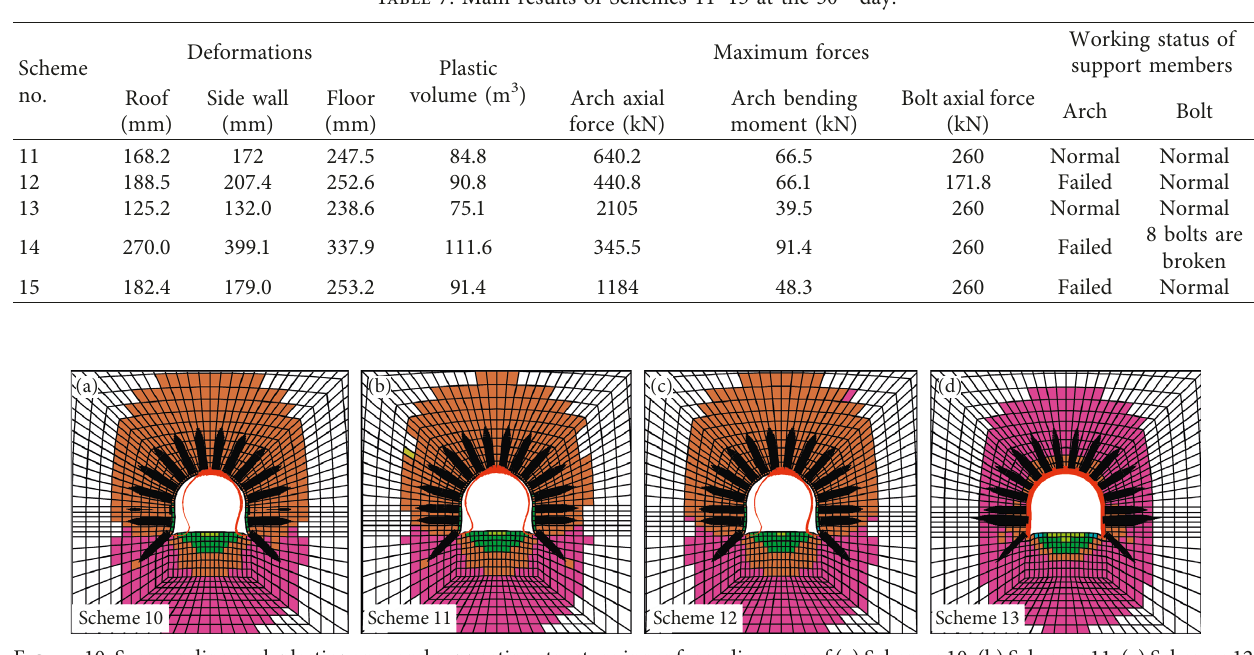
Figure 10: Surrounding rock plastic zones and supporting structure inner force diagrams of (a) Schemes 10, (b) Schemes 11, (c) Schemes 12, and (d) Schemes 13 at the 50 th